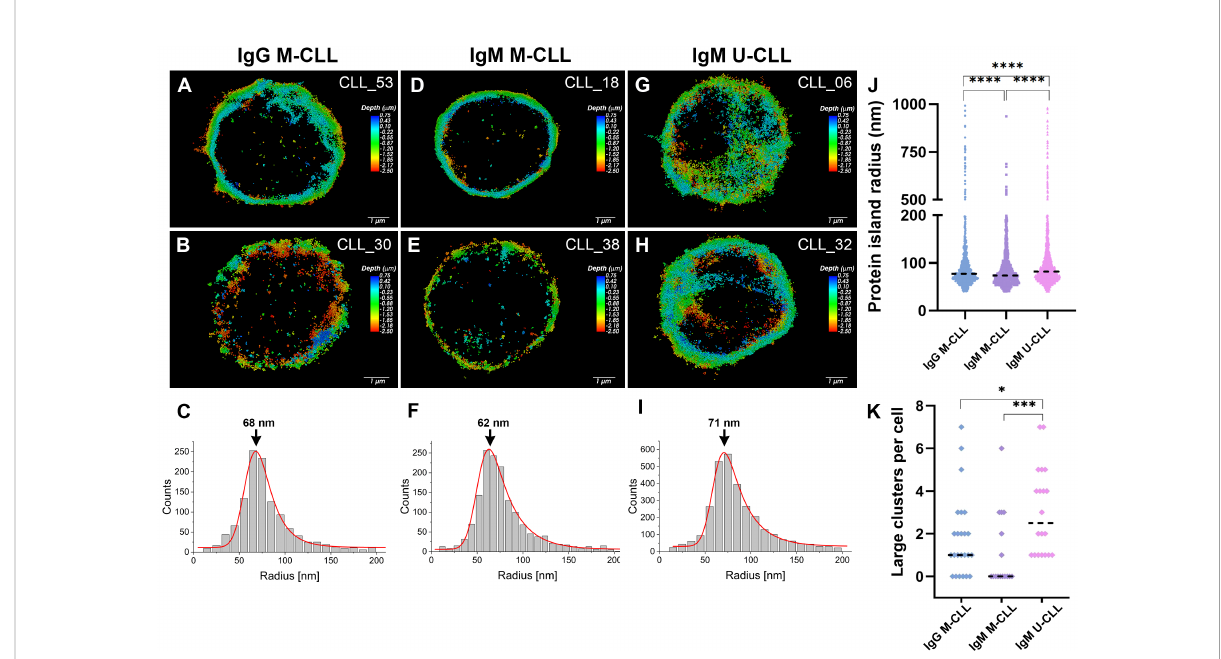
FIGURE 6 IgM and IgG imaging and cluster analysis using d-STORM. Typical three-dimensional d-STORM images of (A, B) patients with IgG M-CLL, (D, E) patients with IgM M-CLL, and (G – H) patients with IgM U-CLL. Images are x-y projections of individual BcR localizations, in which the depth (distance along the z axis) is shown in color coded manner. (C, F, I) Statistical distribution of BcR small cluster size (range of 40 – 200 in radius) in IgG M-CLL, IgM M-CLL, and IgM U-CLL groups, respectively. The peak value of the Gaussian fi t (in red) is marked with an error. (J) Radius distribution of protein islands at the cell membrane for IgG M-CLL, IgM M-CLL, and IgM U-CLL; median is marked in a black dashed line. ****p < 0.0001. (K) Number of large clusters (500 – 1,000 nm) per cell for IgG M-CLL, IgM M-CLL, and IgM U-CLL; mean value with one standard deviation is marked in black. *p < 0.05 and ***p <